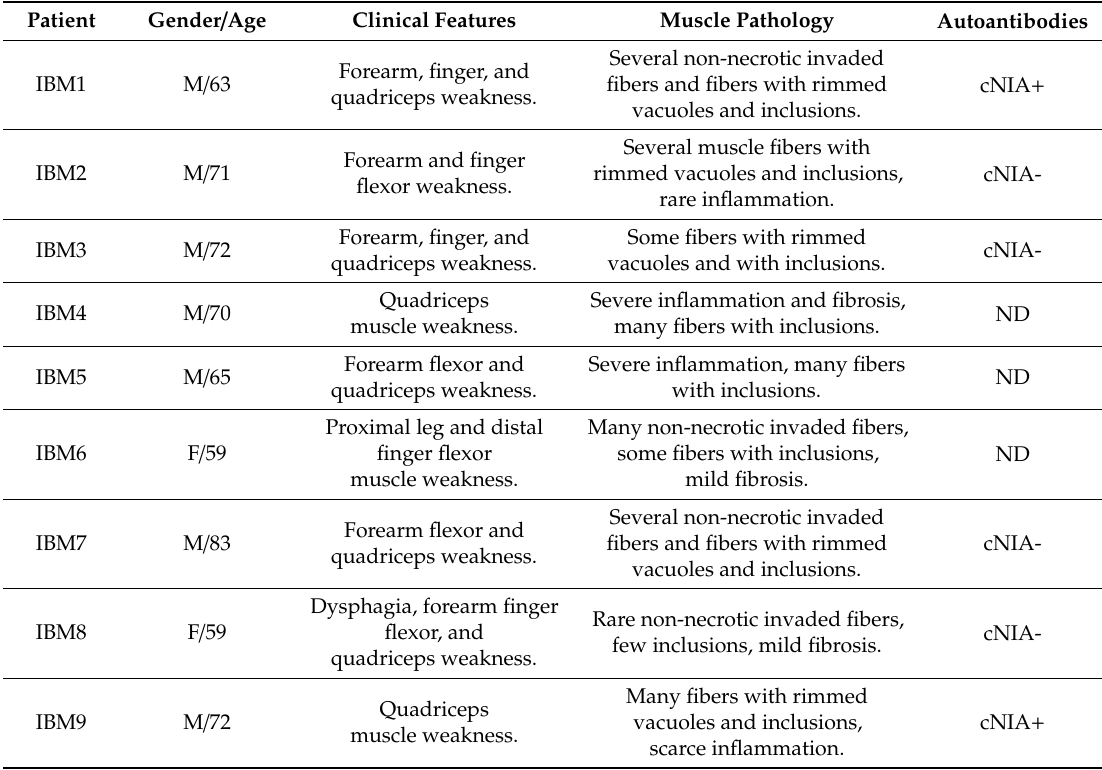
Table 1. Sporadic inclusion body myositis (IBM) patient characteristics.